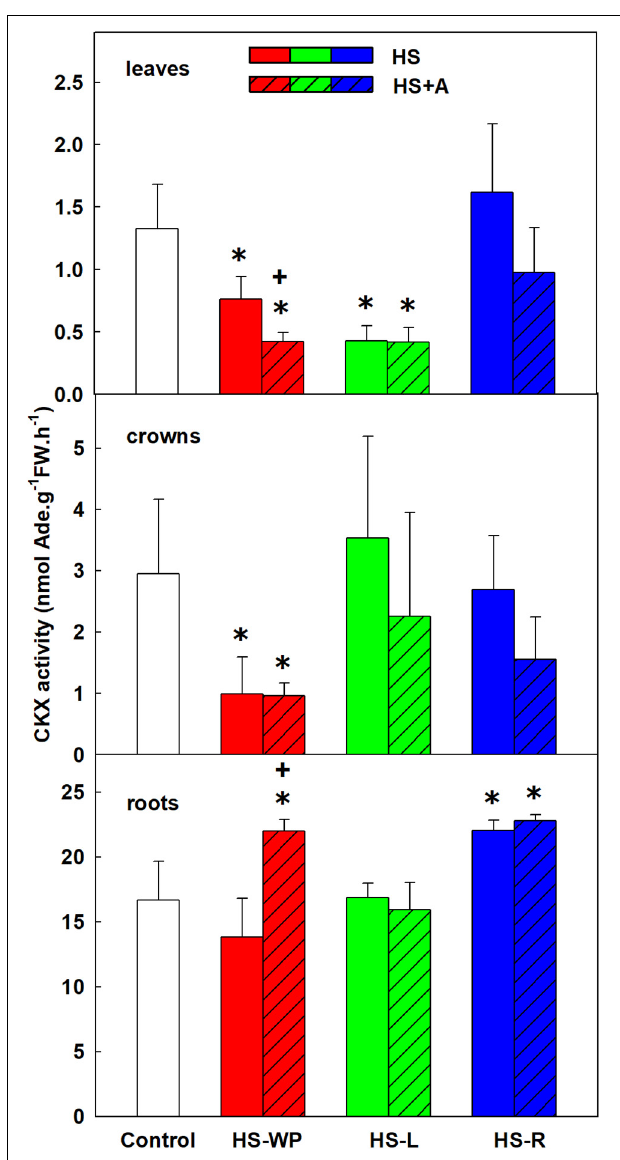
FIGURE 13 | The activity of cytokinin oxidase/dehydrogenase (CKX) in leaves, crowns and roots of rice seedlings exposed to heat stress directly (HS) or after acclimation (HS + A). Heat stress was applied to whole plants (HS-WP), to leaves (HS-L), or to roots (HS-R). Data are means ± SD. One-way ANOVA with Tukey’s post hoc test ( p < 0.05, n = 3) was used to compare controls to the HS treatments. Significant differences compared to control plants are indicated by asterisks ( ∗ ) while crosses (+) indicate significant differences between HS and HS + A